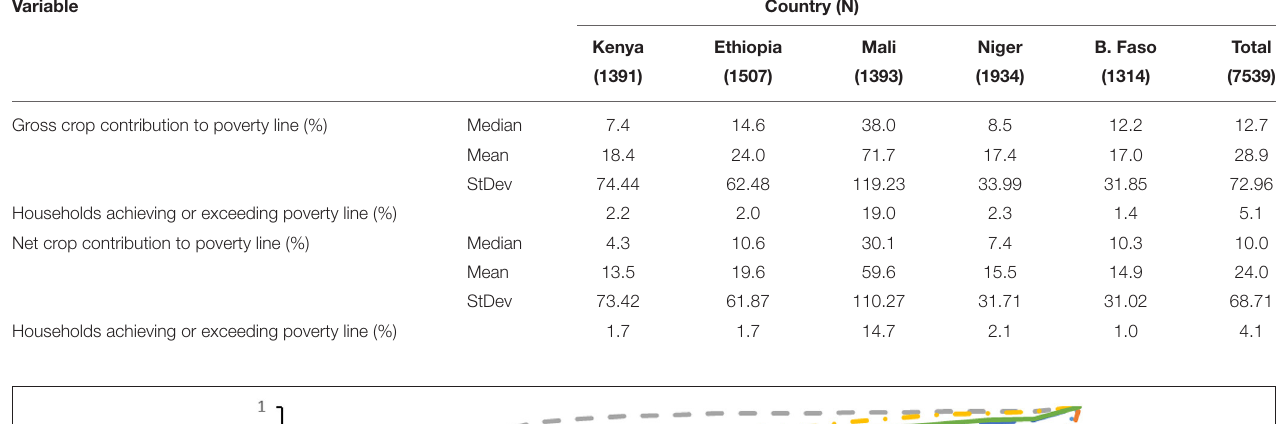
TABLE 3 | Gross and net crop contribution toward generating $1.90 per person per day.